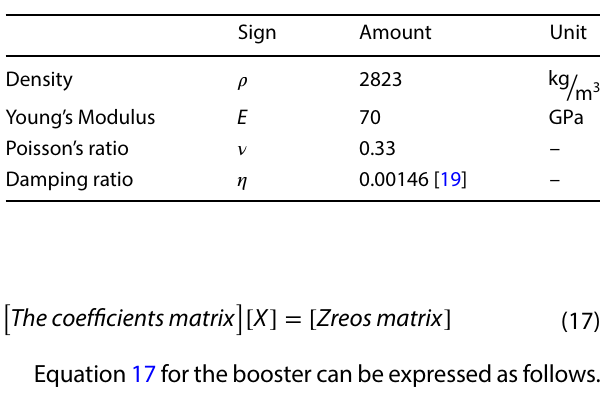
Fig. 4 The horn elements and boundary